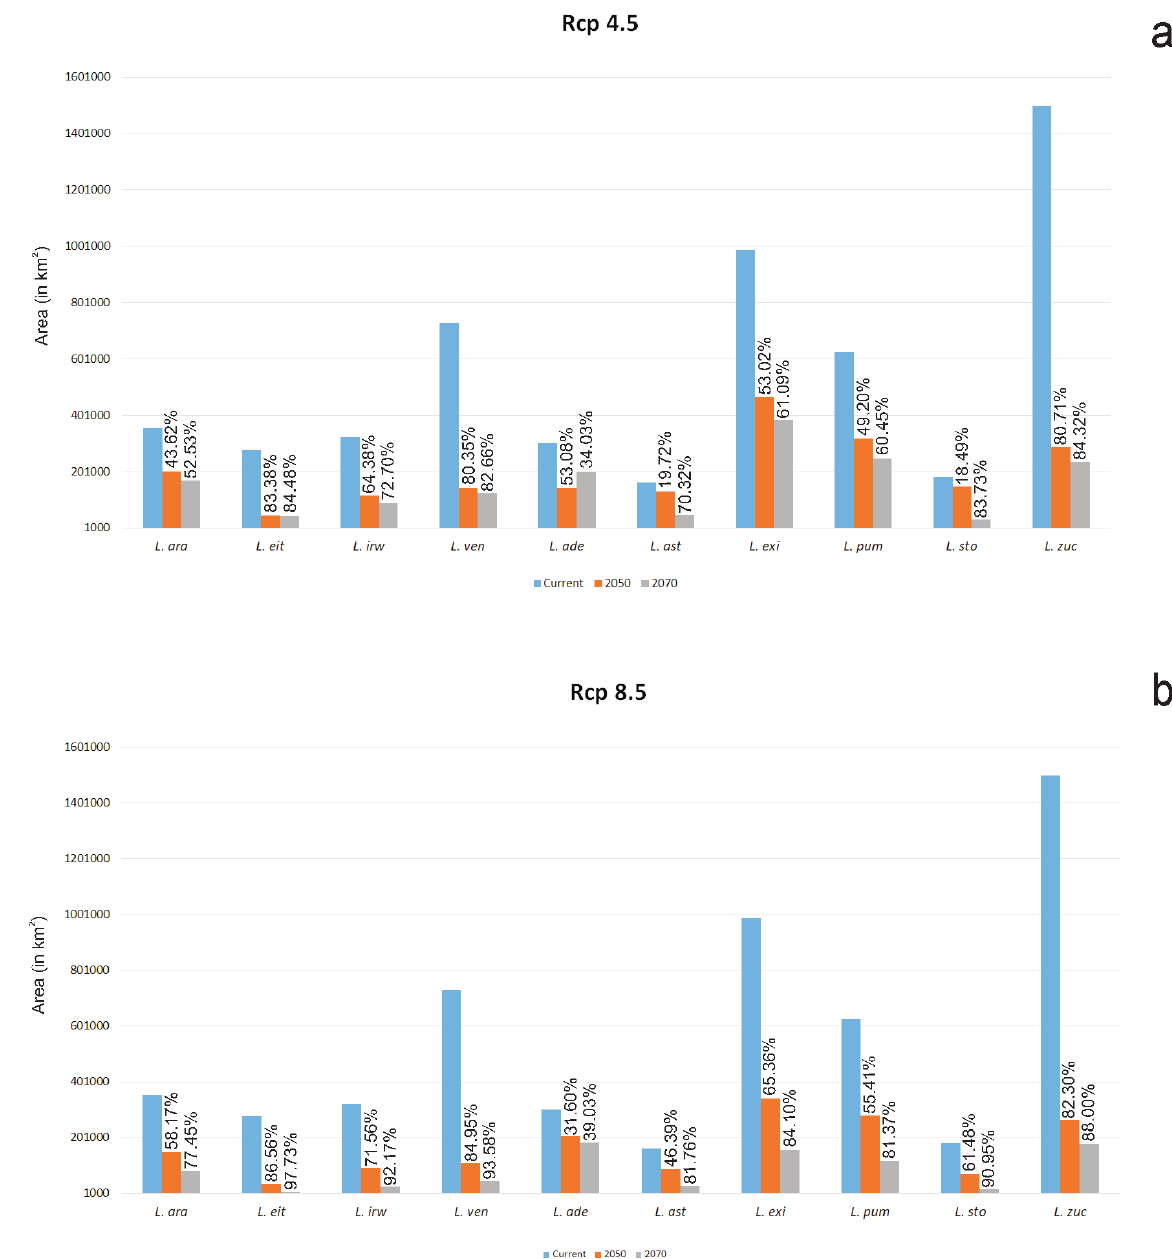
Figure 3. Area (km 2 ) occupied by Lessingianthus species in the present and future (2050 and 2070). (a) Under optimistic scenario (RCP 4.5). (b) Under pessimistic scenario (RCP 8.5). Percent of loss of optimum habitat area with respect to the estimated optimum area for the